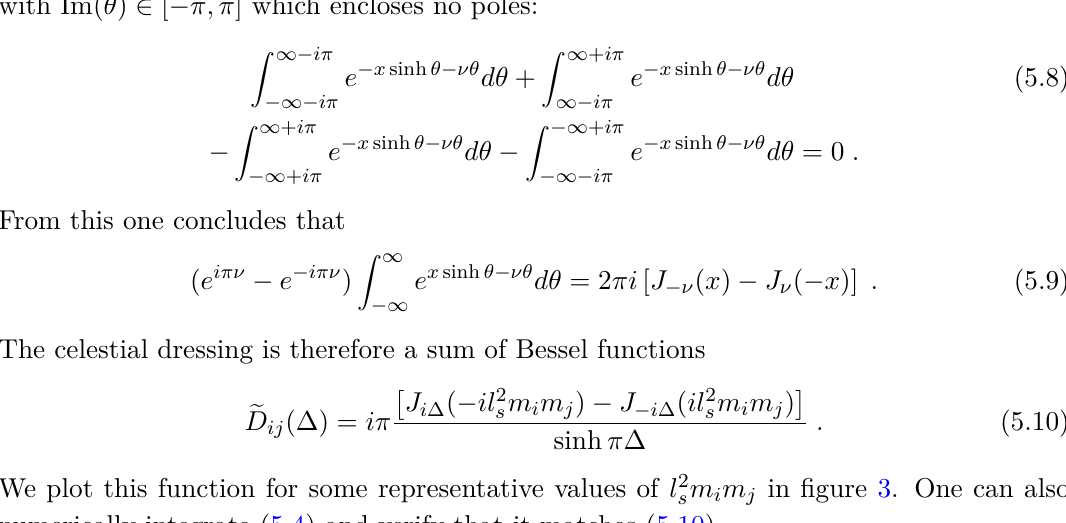
Figure 3 . The celestial dressing, e D ij (∆) , for l 2 l 2 m i m j = 1 (stronger gravity, right hand s